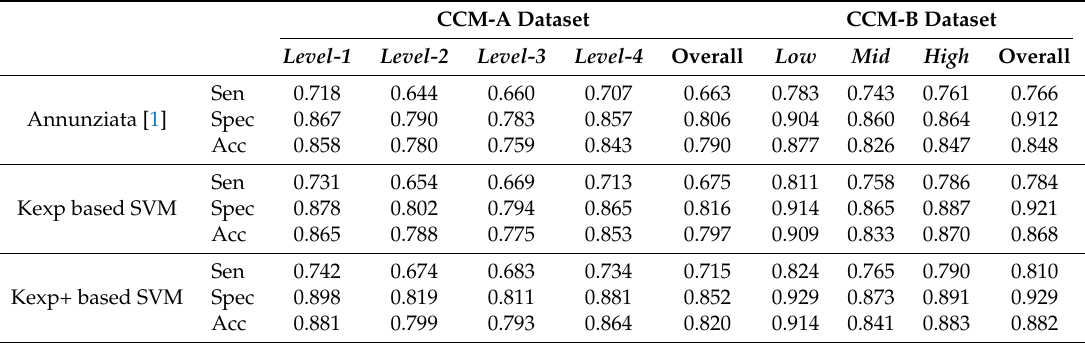
Table 2. Comparison results of tortuosity classification on CCM-A and